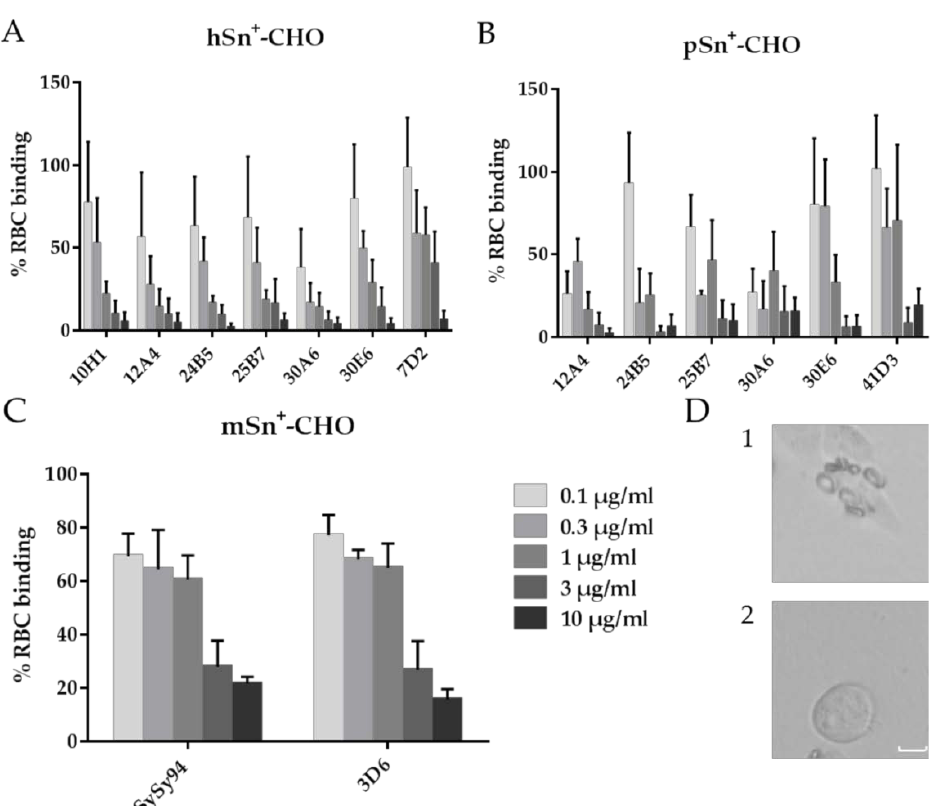
Figure 5. Analysis of red blood cell (RBC) binding inhibition on Sn + -cells. ( A ) hSn + -; ( B ) pSn + -; and ( C ) mSn + -CHO cells were treated with Vibrio cholerae neuraminidase to remove sialic acids on the cell surface before adding different concentrations of mAbs. MAbs were able to bind Sn and prevent RBC binding before RBC were added. Unbound RBC were washed away and rosette formation was analyzed with light microscopy. Cells were counted to obtain a percentage of positive cells, which are cells bound to at least four RBC. Data show the results of three independent repeats with standard error of the mean. ( D ) Representative light microscopic images of RBC binding to Sn + -cells in the (1) absence or (2) presence of an anti-Sn mAb that blocks sialic acid binding. Scale bar: 10 µm.